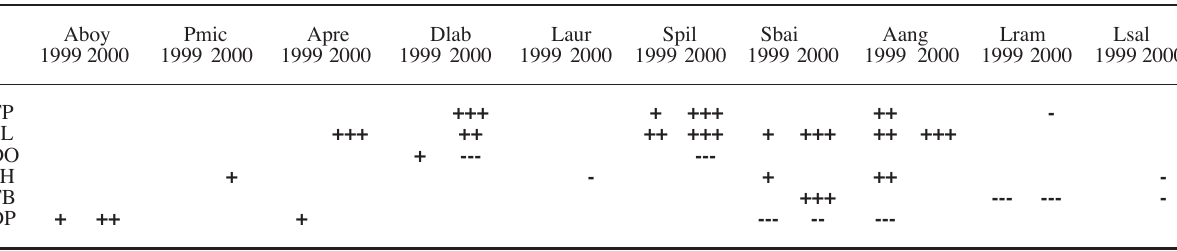
T ABLE 3. – Correlation between fish biomass and environmental factors in 1999 and 2000. Species codes are provided in Table 1. TP, tem- perature (ºC); SL, salinity; OD, dissolved oxygen (mg l -1 ); pH, pH; TB, turbidity (m); DP, depth (m). Significant correlations between species biomass and abiotic parameters are shown. Blanks: p>0.05, (+ or -): p ≤ 0.05, (++ or --): p ≤ 0.01, (+++ or ---): p ≤ 0.001.